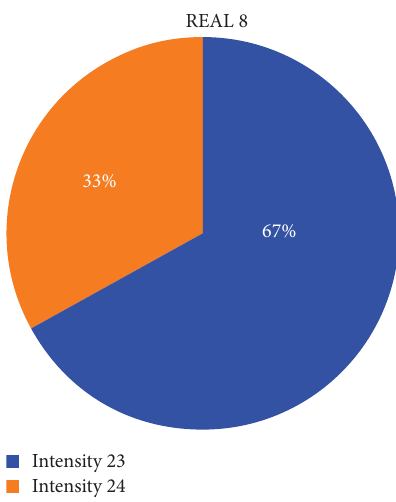
F IGURE 12: REAL 8 result distribution with local search